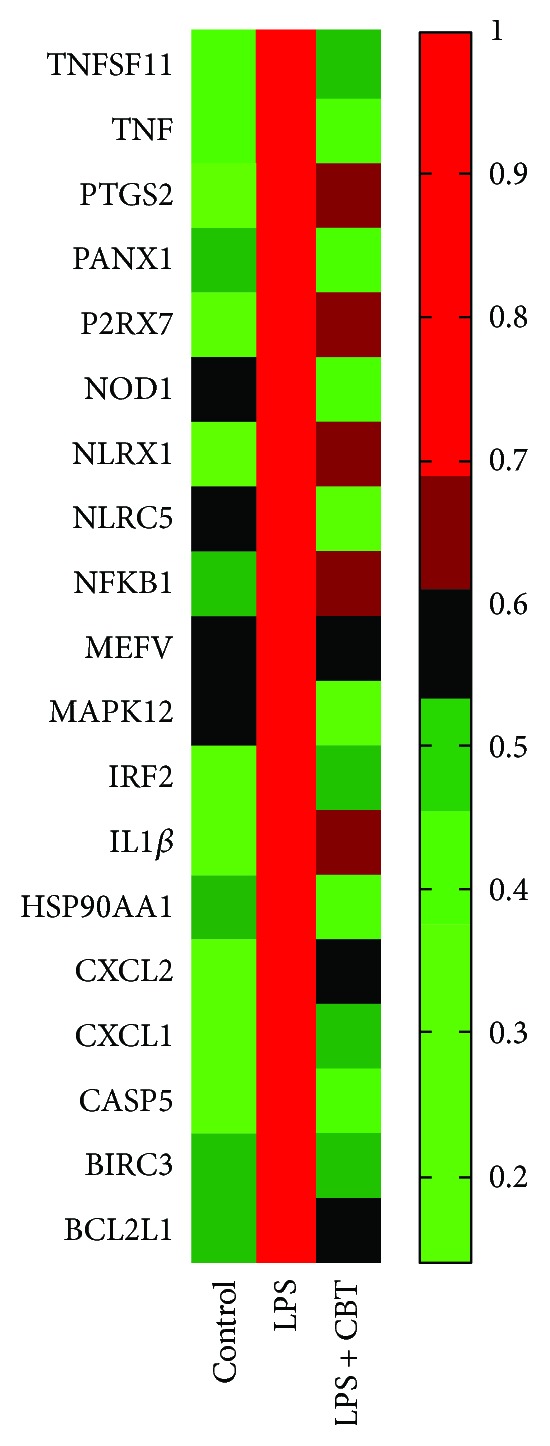
Effects of CBT (40 μg/ml) on the regulation of differential inflammatory-related genes.